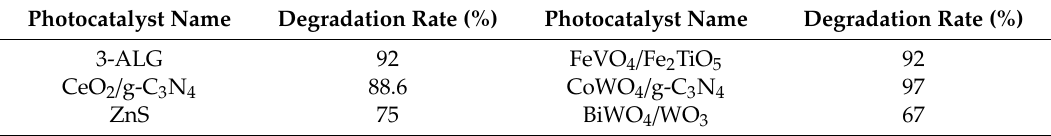
Table 4. Photocatalytic degradation of 3-ALG, CeO 2 / g-C 3 N 4 , ZnS, FeVO 4 / FeTiO 5 , CoWO 4 / g-C 3 N 4 and BiWO 4 / WO 3 .